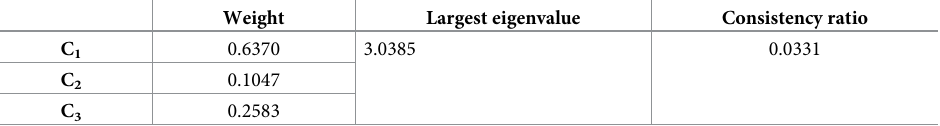
Table 16. Values of the consistency ratio and fuzzy weight vectors and crisp weights in emergency response 1.